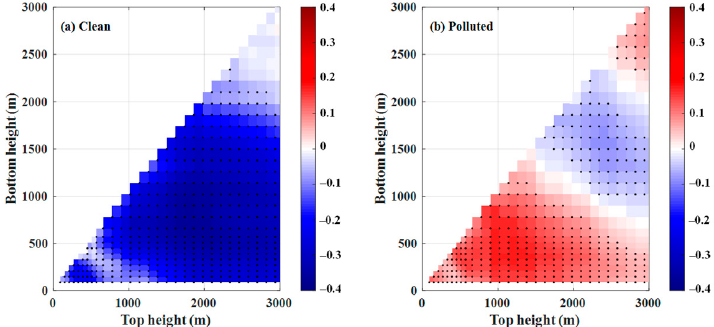
Figure 7. The distributions of correlation coefficients between NPM 2.5 and VWS under ( a ) clean and ( b ) polluted conditions in CS. Black dots indicate the Pearson correlation coefficients passing the confidence level of 90%.